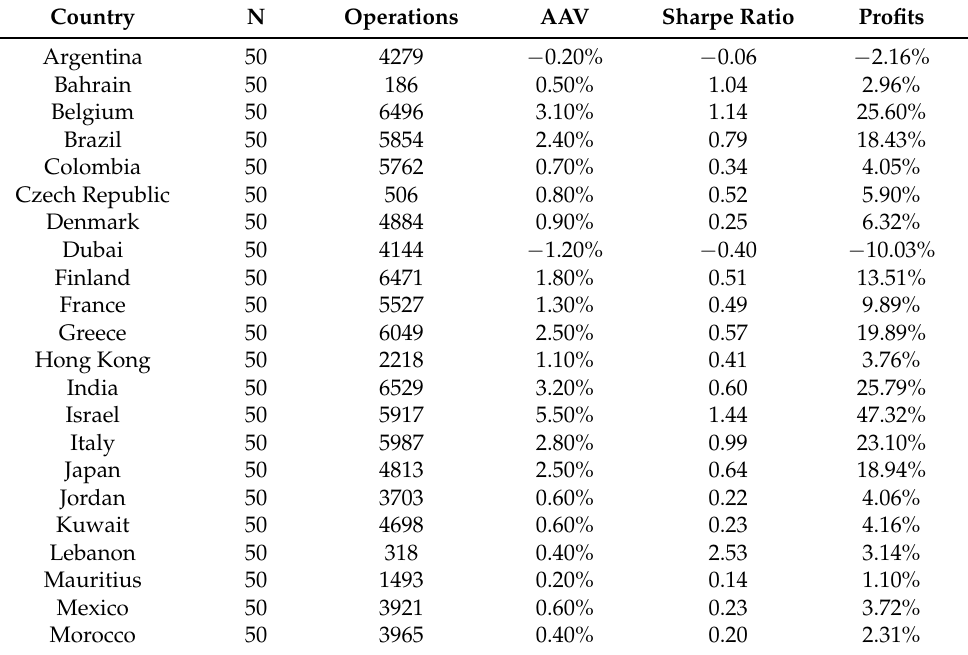
Table A7. Results obtained for the period 2007–2014 (50 Pairs), where N is the number of pairs; AAV Average annualized return; and Profit is the profitability for the full period with transaction